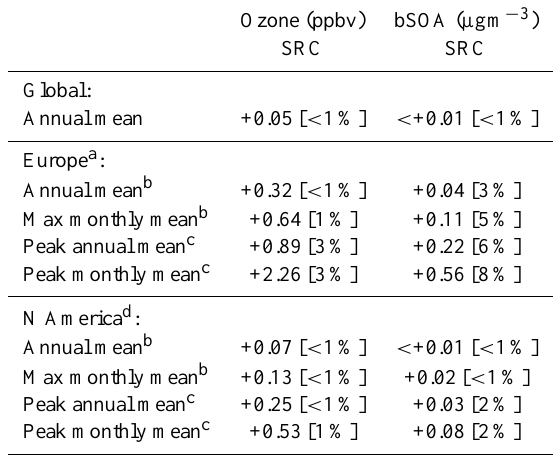
Table 3. Summary of changes in ground-level ozone and biogenic SOA concentrations for the SRC